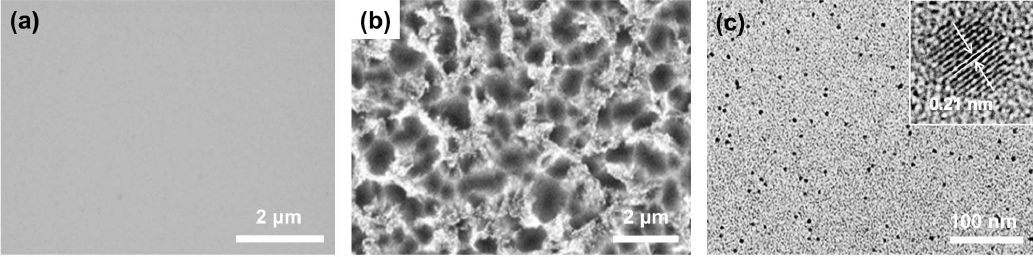
Figure 3. (a) The Raman spectra of the detached GQDs. (b) The atomic force microscope (AFM) image of the GQDs with the thickness graph of GQDs in yellow (the length of the yellow line inside the AFM